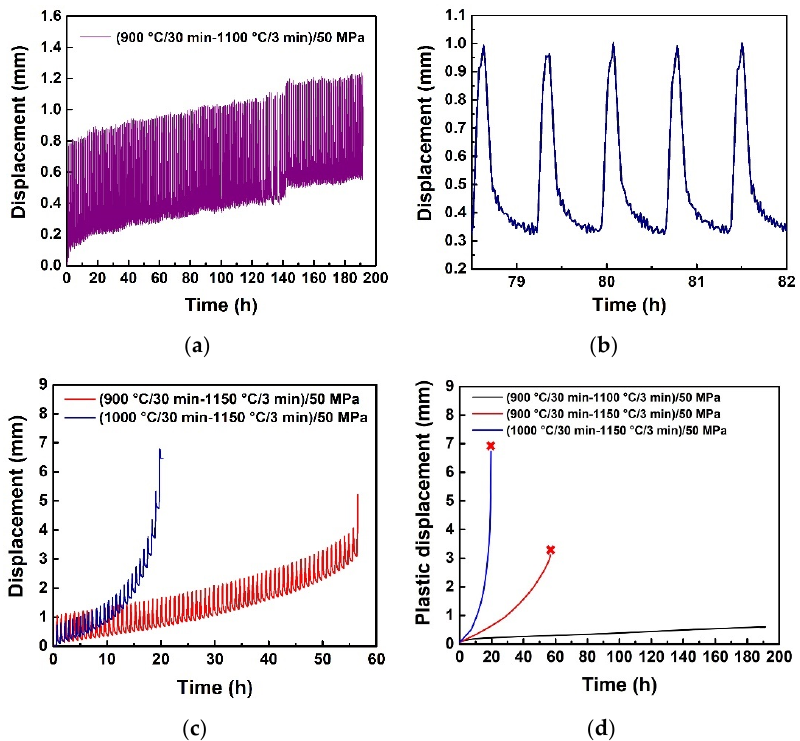
Figure 2. Experimental creep displacement vs. time of the thermal cycling creep under (900 °C/30 min–1100 °C/3 min)/50 MPa ( a , b ), (900 °C/30 min–1150 °C/3 min)/50 MPa and (1000 °C/30 min–1150 °C/3 min)/50 MPa ( c ). ( d ) plastic creep displacement vs. time curves under (900 °C/30 min–1100 °C/3 min)/50 MPa (interrupted), (900 °C/30 min–1150 °C/3 min)/50 MPa (fractured) and (1000 °C/30 min– 1150 °C/3 min)/50 MPa (fractured).